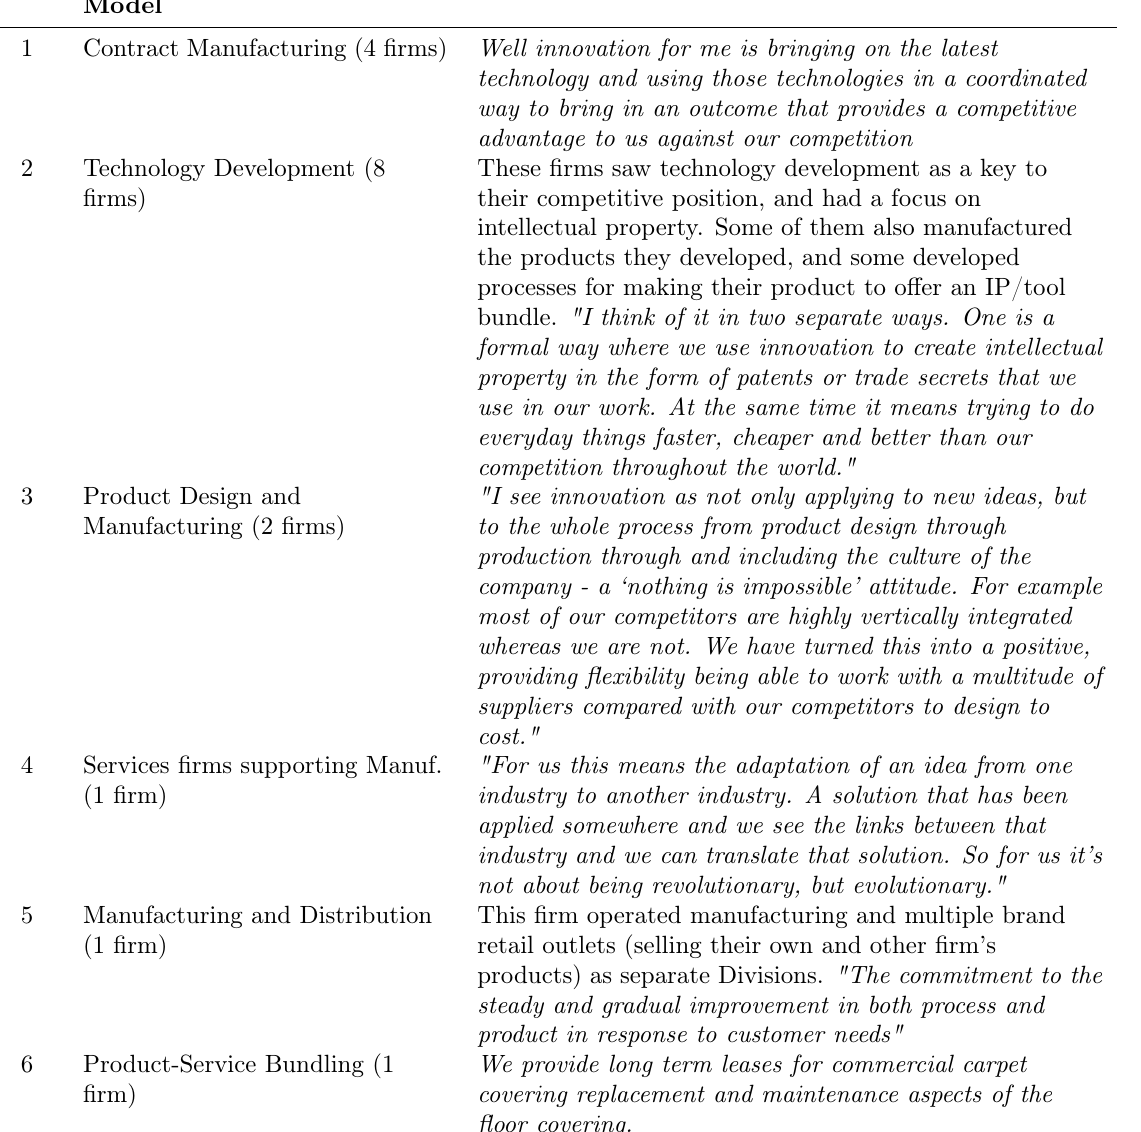
Table 2. Classifications according to business model type Type Characteristic